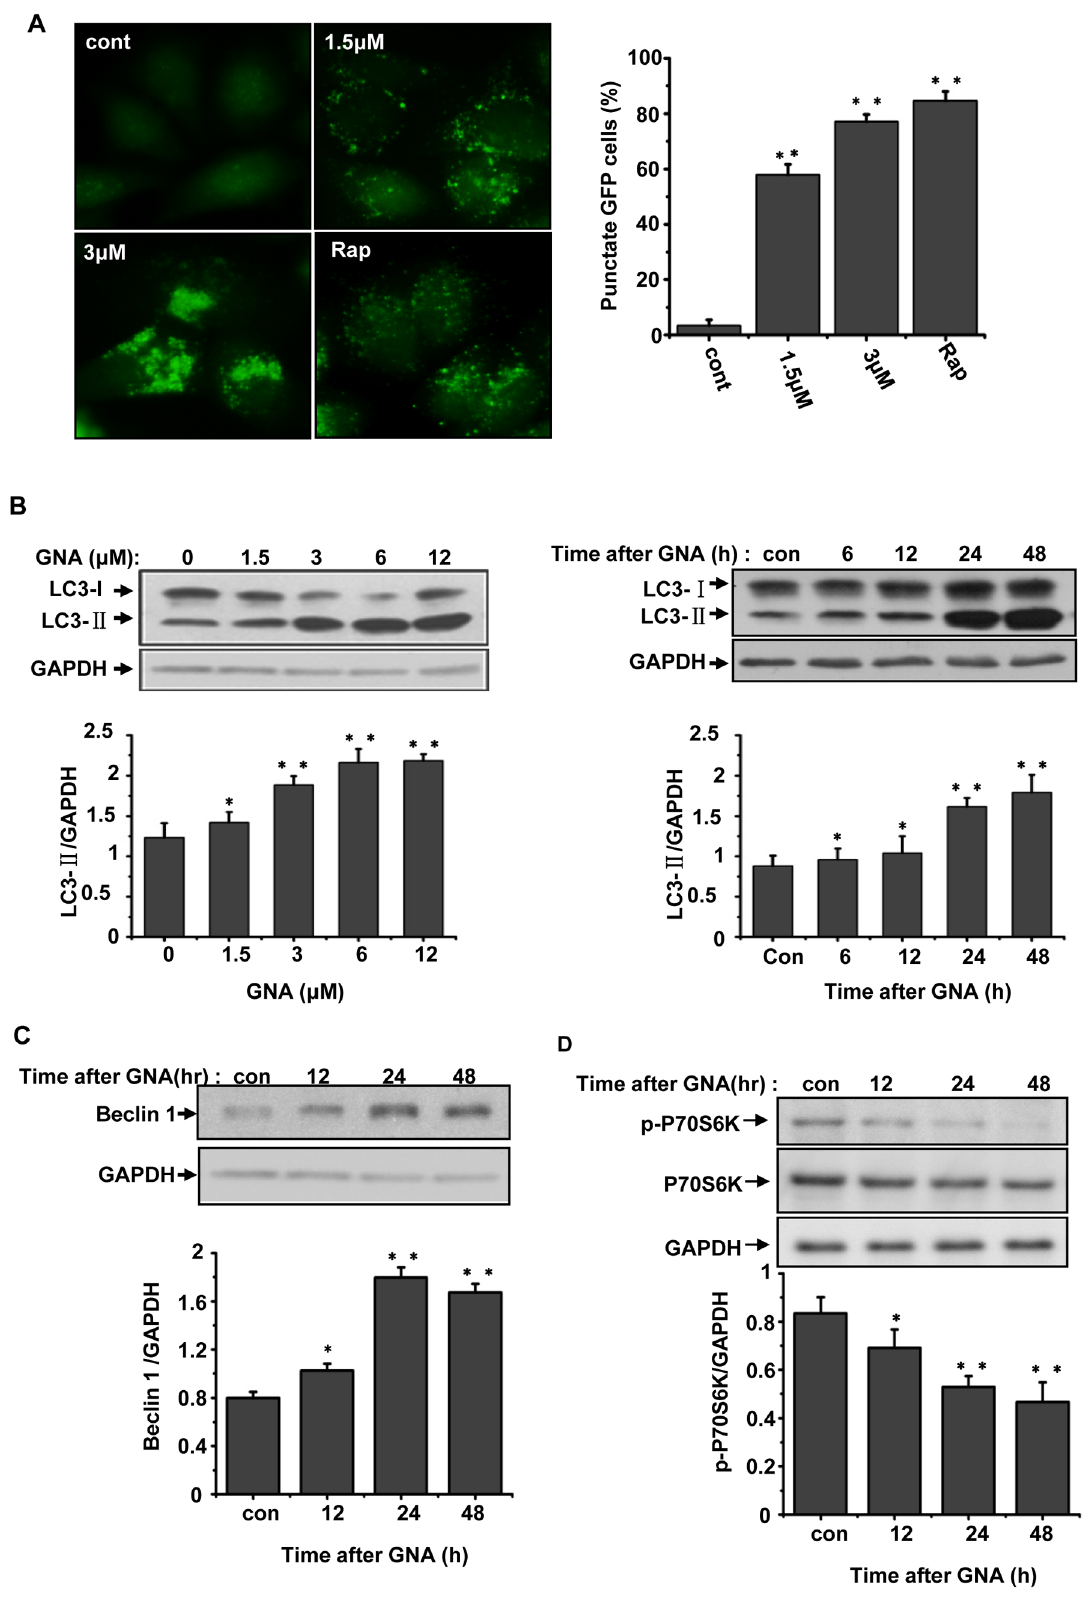
Figure 3. GNA triggers the formation of autophagic markers in A549 and HeLa cell. A, Effects of GNA on the distribution of GFP-LC3 punctuates. GFP-LC3/HeLa cells were treated with various concentrations of GNA or 50 m g/ml of rapamycin for 24 hours, then detected by fluorescence microscopy. The percentage of cells with at least 5 GFP-LC3 punctuate dots was calculated; at least 600 cells were observed, Means 6